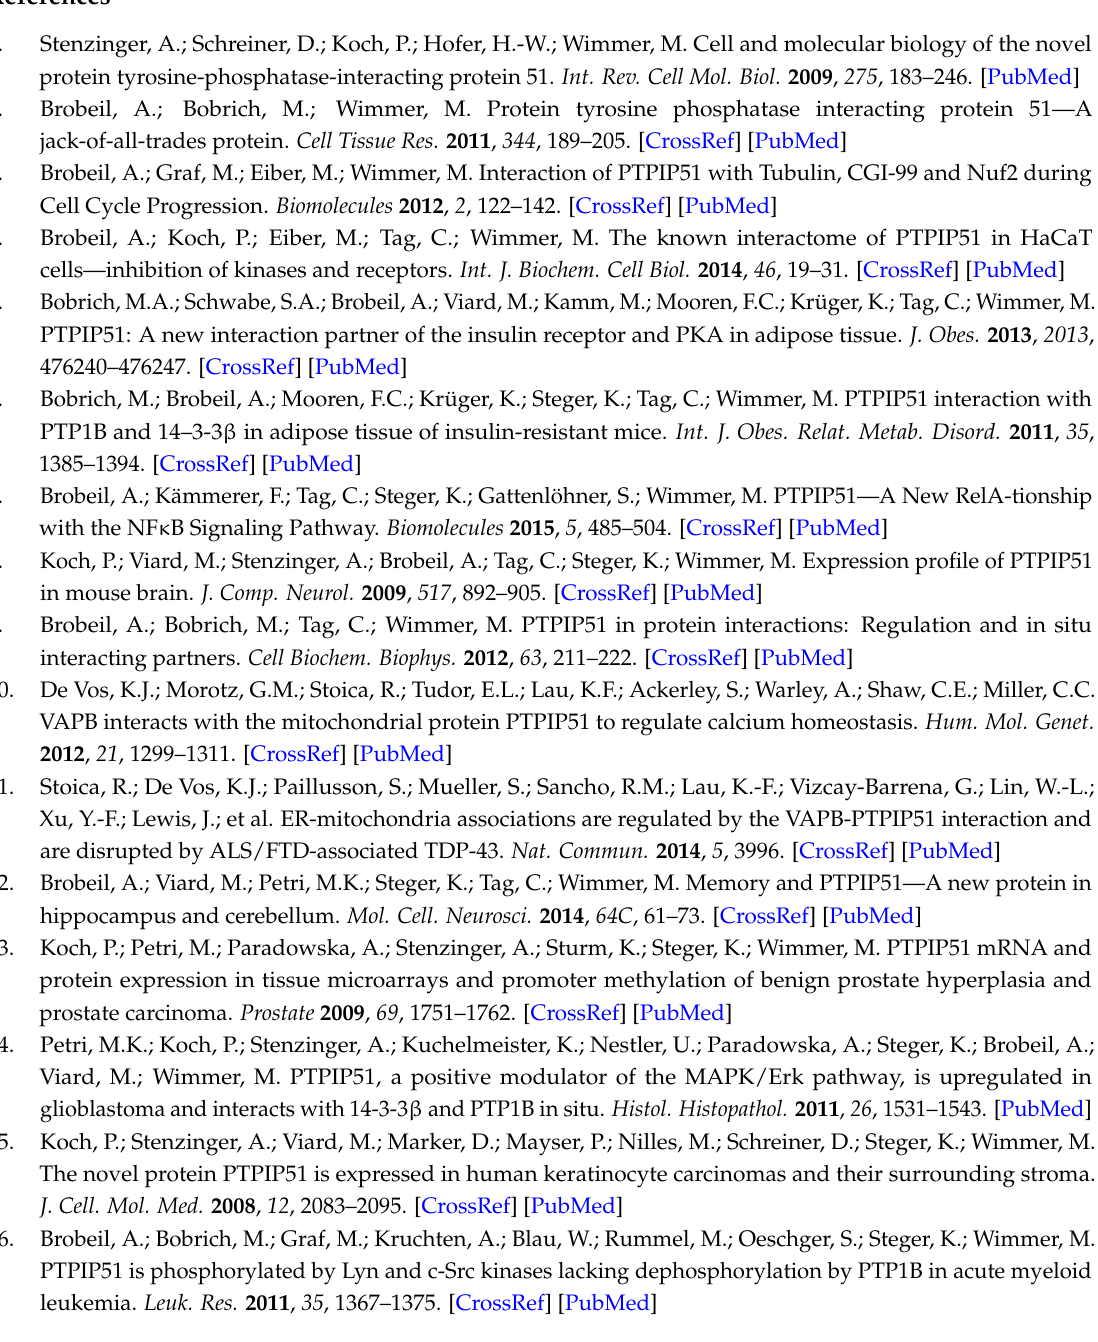
Figure S6: Stain-free blot for quantification, Figure S7: Semiquantitative analyses of the Tyr176 phosphorylation status of PTPIP51, Figure S8: Semiquantitative analyses of the Ser46 phosphorylation status of PTPIP51, Figure S9: Semiquantitative analyses of the Ser212 phosphorylation status of PTPIP51, Table S1: Antibody